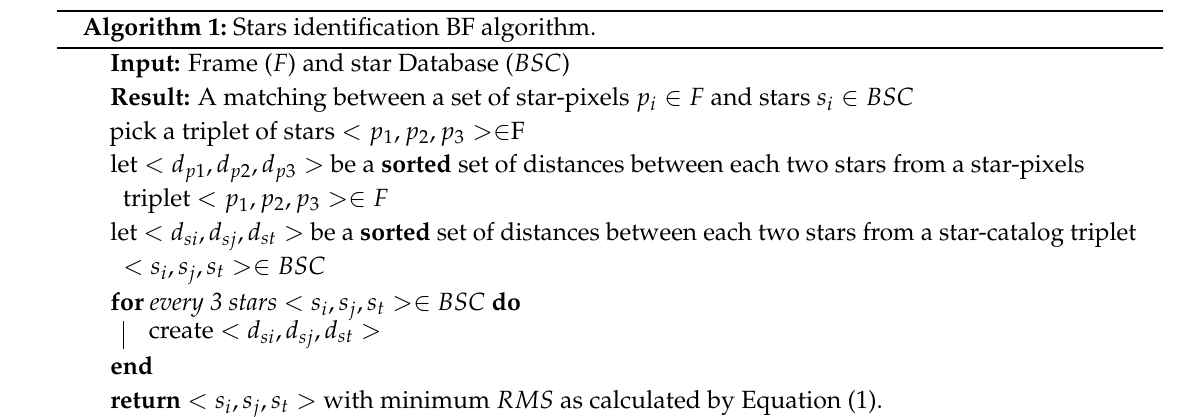
Algorithm 1: Stars identification BF